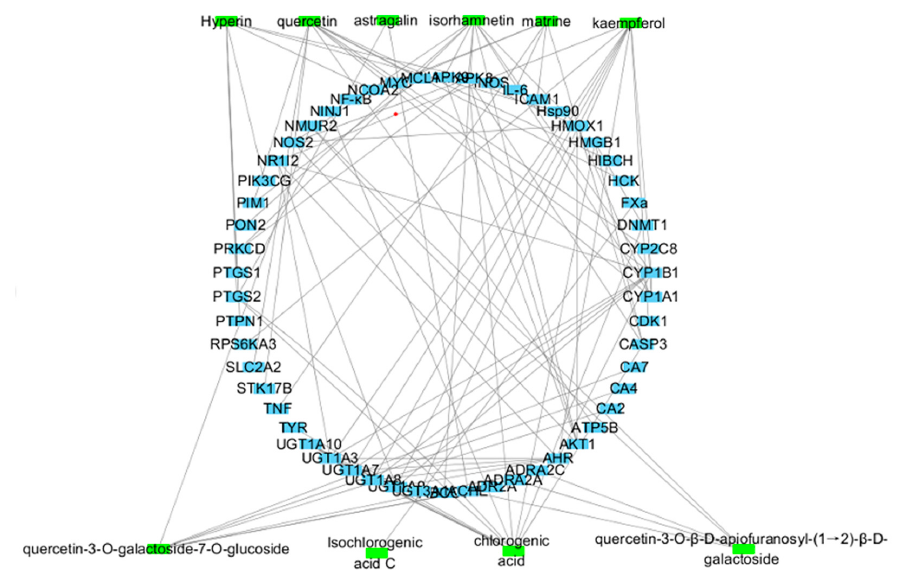
Figure 6. Active compounds–targets network. Green represents the active components; blue represents the targets of the components.